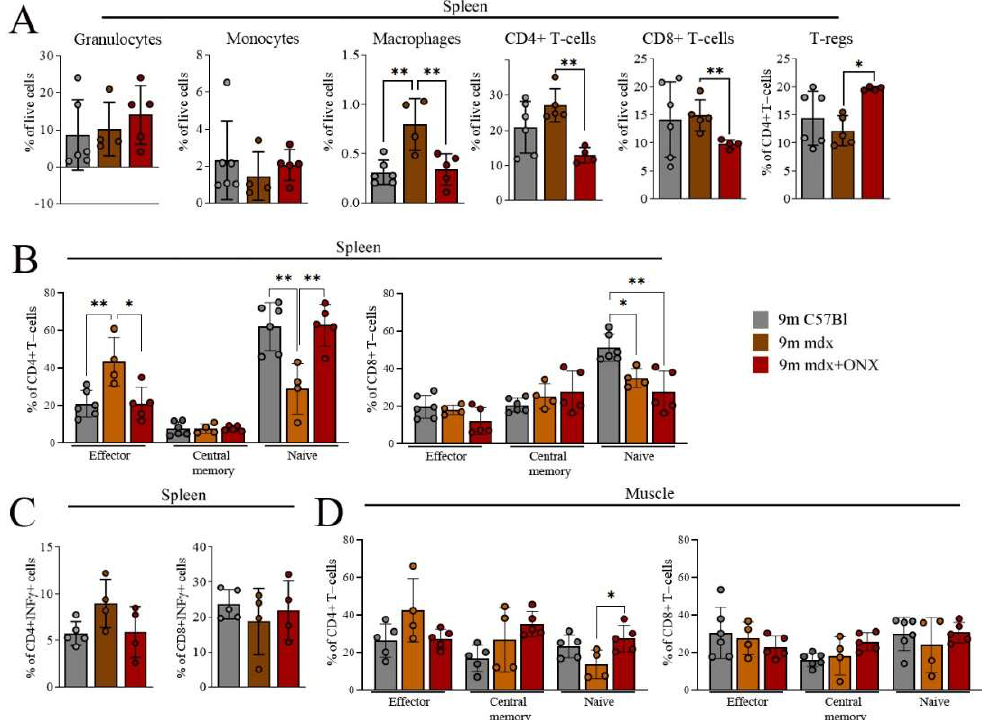
Figure 3. FACS analysis of immune cell population from spleen and skeletal muscles of 9m C57Bl, 9m mdx and 9m mdx+ONX mice. FACS analysis was performed on spleen and muscle homogenates from C57Bl, 9m mdx and 9m mdx+ONX mice. Panels for spleen show ( A ) percentages of granulocytes (Ly6g+), monocytes (Ly6c+), macrophages (F4/80+CD11b+), CD4+ and CD8+ T cells, and Tregs (FOXP3+ on CD4+ T-cell gate); ( B ) frequency of effector (CD62L − CD44+), central memory (CD62L+CD44+) and naïve (CD62L+CD44 − ) T cells within the CD4+ or CD8+ populations; ( C ) frequency of CD4+ and CD8+ IFN γ -producing cells. ( D ) Panel for muscle displays frequency of effector (CD62L − CD44+), central memory (CD62L+CD44+) and naïve (CD62L+CD44) T-cells within the CD4+ or CD8+ populations. Data are expressed as means ± SD of n = 2 independent experiments with n = 6 C57Bl mice and n = 4–5 9m mdx and 9m mdx+ONX mice (* p < 0.05, ** p < 0.01, with ordinary one-way ANOVA, Tukey’s multiple comparison test).